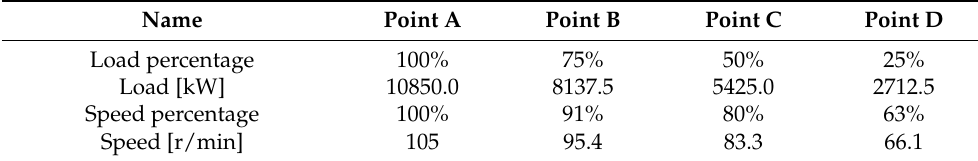
Table 5. Parameters of the diesel engine operating